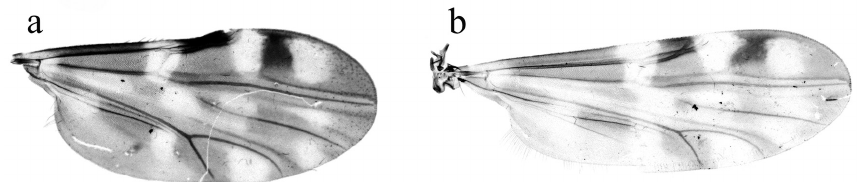
Figure 1. Culicoides ( A. ) fenggangensis sp. n. Left Wing. a Female b Male.